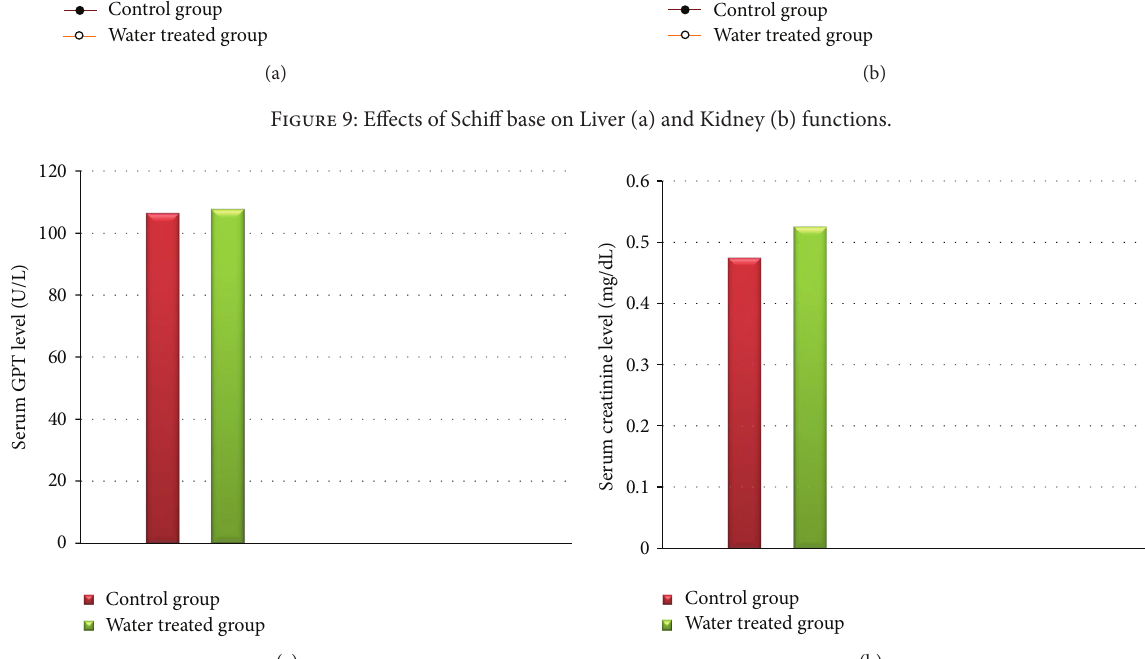
Figure 10: (a) Effect of Schiff base on serum ALT activity. (b) Effect of Schiff base on serum creatinine concentration